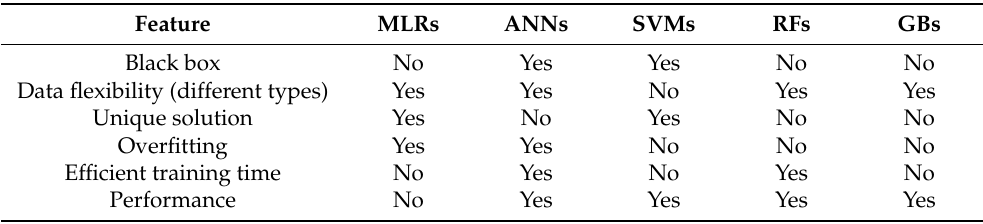
Table 4. Basic overview of all implemented algorithms where each of them are compared to understand their advantage and disadvantage (personal communication Irina Emelyanova, 2020).